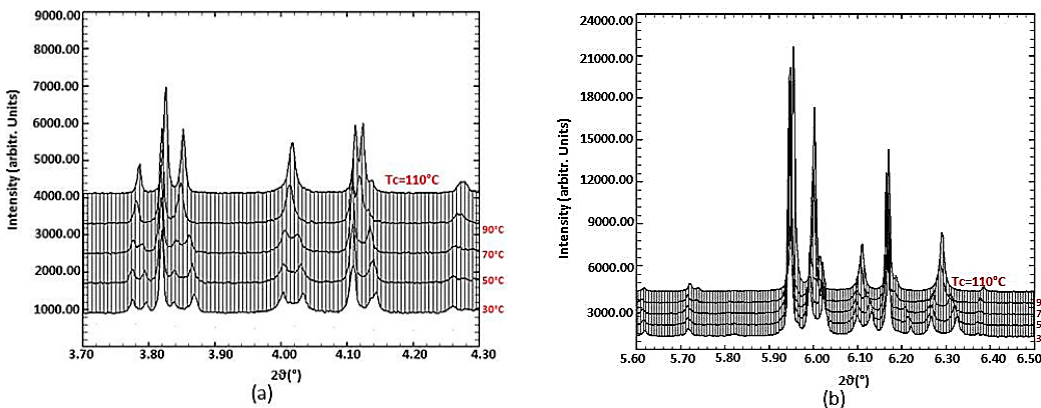
Figure 2. Evolution of the investigated ZSM-5-MTBE close to the expected transition temperature (30, 50, 70, 90 and 110 °C , respectively) in the 3.70–4.30 ( a ) and 5.60–6.50 ( b ) 2 θ (°) range.